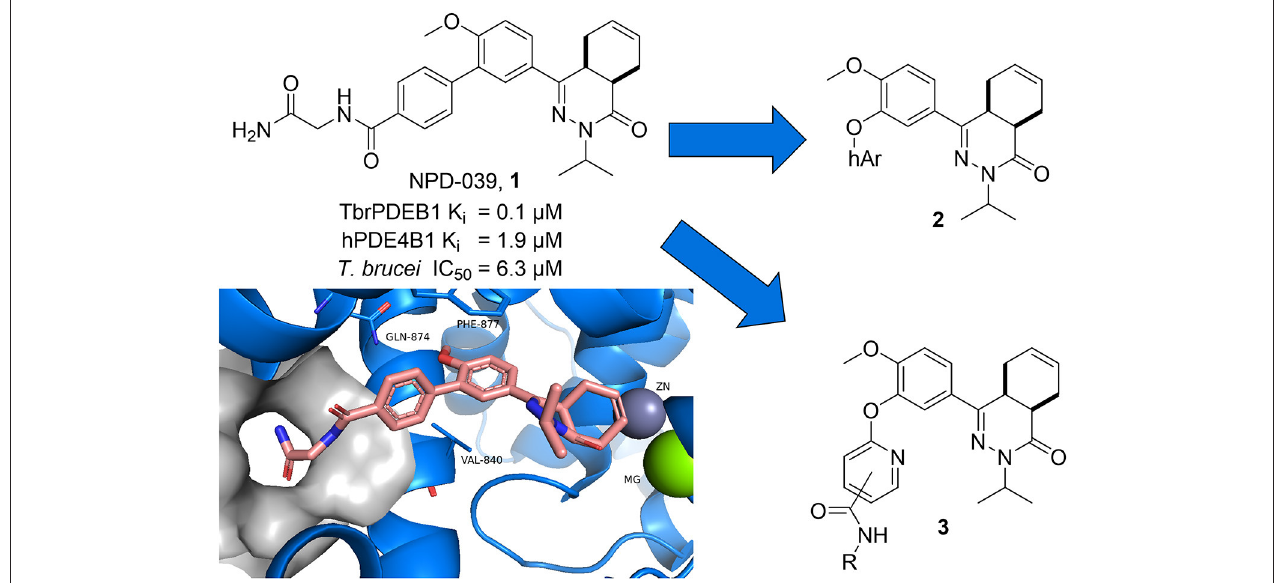
FIGURE 1 | Design ideas based on reported biphenyl phthalazinone NPD-039 (1) based on virtual screening using the co-crystal structure of 1 (PDB: 5L8C) and heteroaryl chlorides (2) and structure-guided design